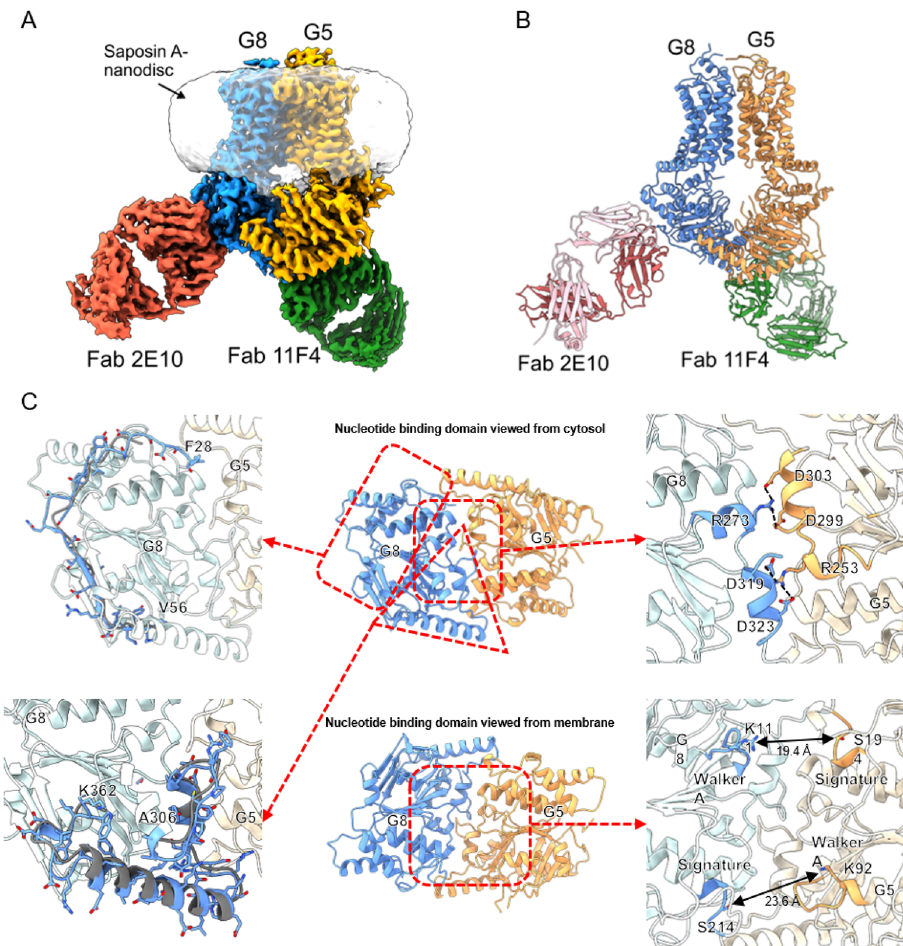
Fig. 2 Structure of ABCG5/G8 in complex with Fab 2E10 and Fab 11F4. A Cryo-EM map of ABCG5/G8 complexed with Fab 2E10 and Fab 11F4 in saposin A nanodisc. B Overall structure of ABCG5/G8 complexed with Fab 2E10 and Fab11F4. Heavy chain and light chain of Fab 2E10 are colored in red and light red, respectively. Heavy chain and light chain of Fab11F4 are colored in green and light green, respectively. C Structural details of ABCG5/G8 nucleotide- binding domains. Middle: the nucleotide-binding domains of ABCG5/G8 viewed from the cytosol (top) and membrane (bottom) sides. Top left: registry correction of amino acid residues, 28 – 56, in ABCG8 (blue, this study). Amino acid residues 24 – 44 from the crystal structure of ABCG5/G8 (PDB 5DO7) are shown in gray for comparison. Bottom left: registry correction of amino acid residues, 306 – 362, in ABCG8 (blue, this study). Amino acid residues 306 – 355 from the crystal structure of ABCG5/G8 (PDB 5DO7) are shown in gray for comparison. Top right: bottom view of ABCG5/G8 shows that the NPXDFXXD motifs from both ABCG5 and ABCG8 occupy the center location of a three-helix bundle and make the symmetric dimer interface between the NBDs. Bottom right: separation between ABCG5 signature motif and ABCG8 Walker A motif and between ABCG8 signature motif and ABCG5 Walker A